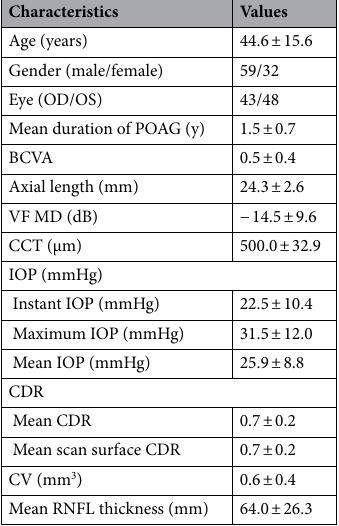
Table 1. Clinical characteristics of study participants (n = 91). BCVA = best-corrected visual acuity; CCT = central corneal thickness; CDR = cup-disk ratio; CV = cup volume; IOP = intraocular